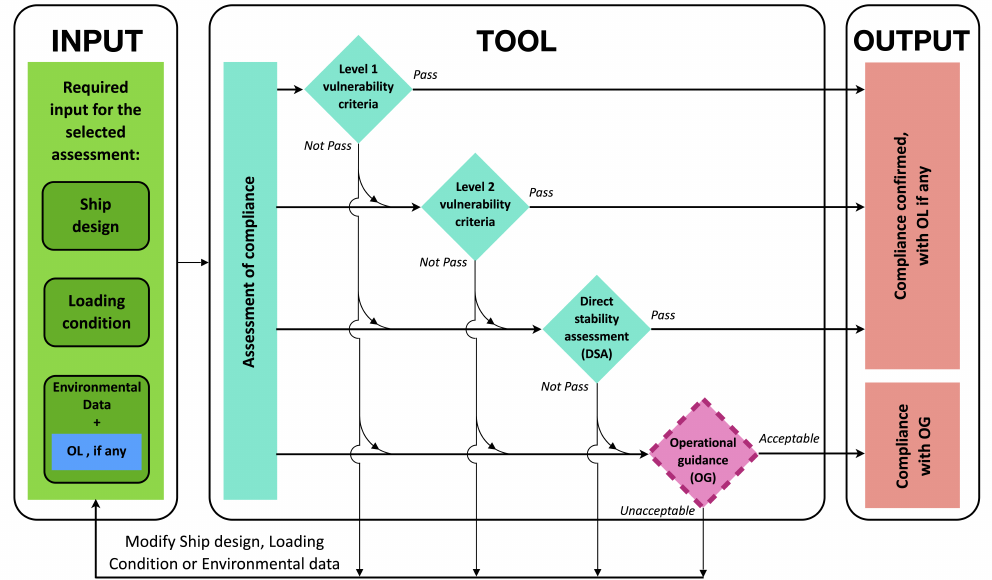
Figure 1. Representation of the simplified application scheme of the application logic in the Second Generation Intact Stability criteria (SGISc)